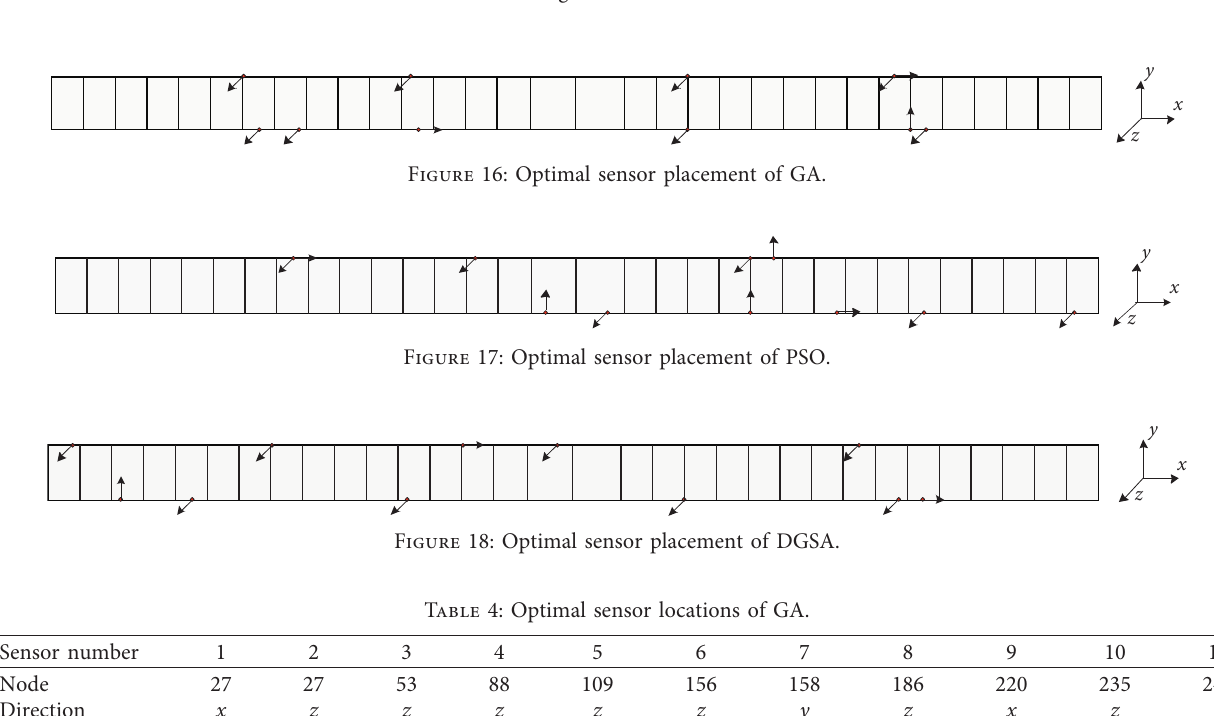
Figure 15: Maximum off-diagonal term at each mode in MAC matrix.